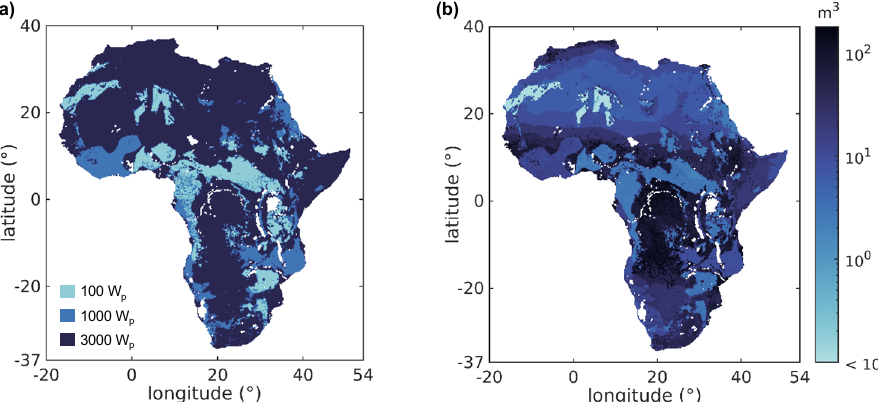
Fig. 6 Best performing PVWPS size and associated pumped volume for 2020. Size values are given in a and volume values in b . The results are plotted in a blue